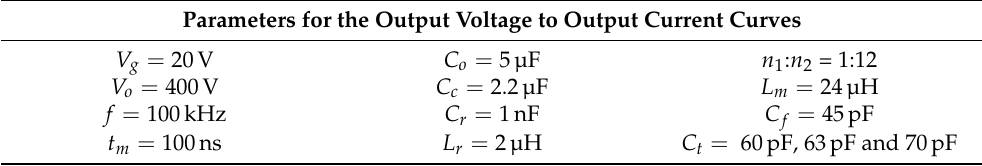
Table 1. Active clamp flyback parameters that were used to obtain the curves in Figure 4. Parameters for the Output Voltage to Output Current